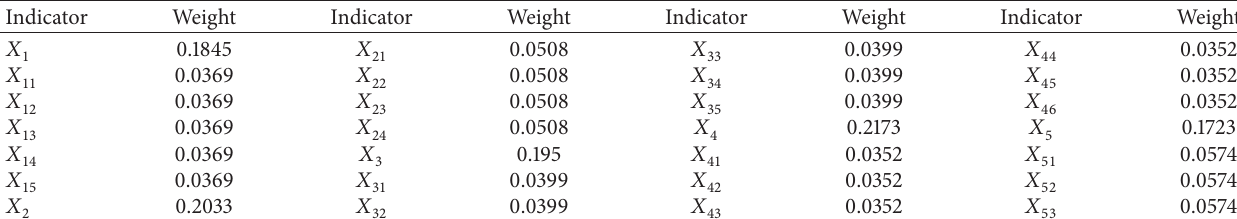
Table 3: Index weights based on the improved fuzzy analytic hierarchy process.